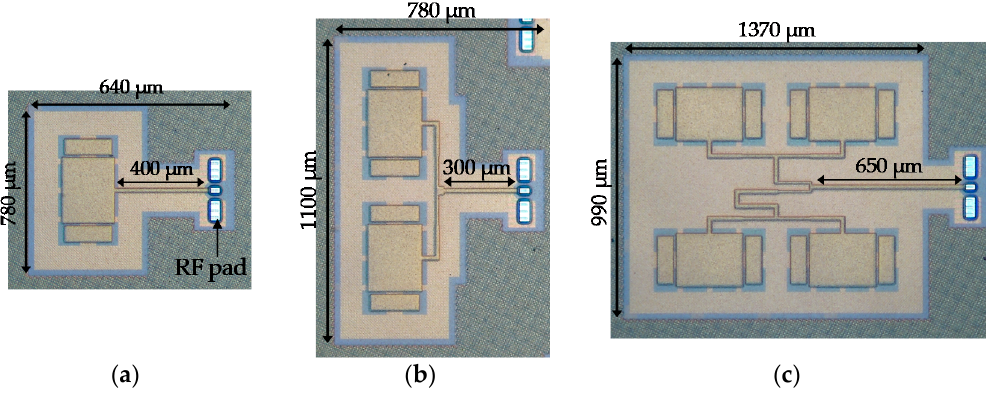
Figure 9. Photographs of fabricated on-chip antenna in a 65 nm CMOS process. ( a ) Antenna element. ( b ) The 1 × 2 antenna array. ( c ) The 2 × 2 antenna array.